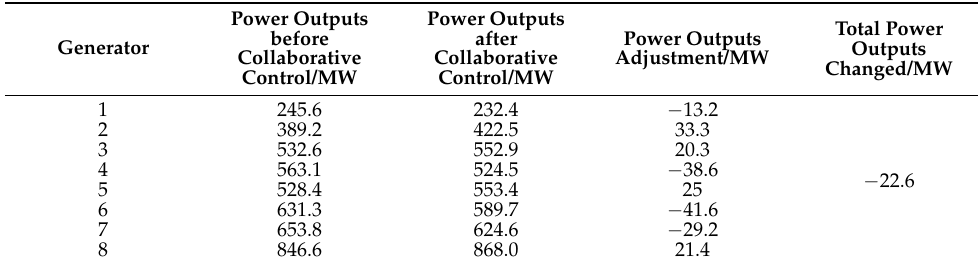
Table 4. Comparison of generators’ active power outputs before and after collaborative transient stability control of IEEE 30 bus system.